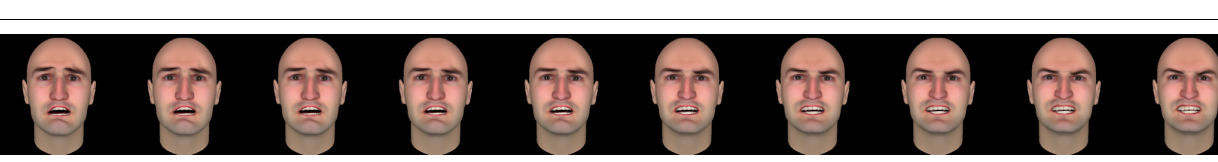
FIGURE 2 | Final frames of the movies from all ten different morph levels for one particular identity. From left to right: 0%, 10%, 20%, 30%, 40%, 60%, 70%, 80%, 90%, and 100% anger.